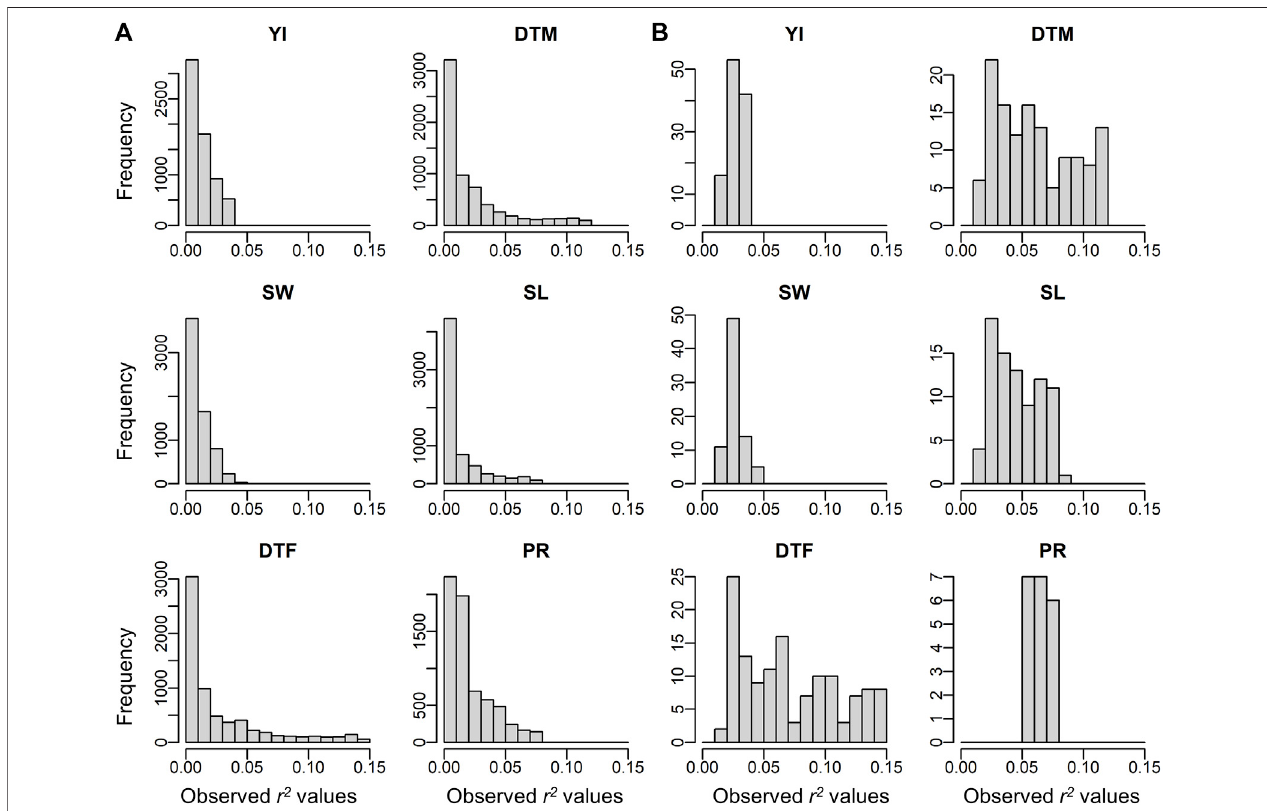
FIGURE 4 | Observed r 2 values of off-diagonals between the similarity matrix of environmental covariates and the genetic correlation matrix. (A) Histograms for all environmentalcovariates. (B) Histogramsfortheenvironmentalcovariatessigni fi cantlydetected.Abbreviations:YI,yield;SW,seedweight;DTF,daysto fl owering;DTM, days to maturity; SL, stem length; PR, protein